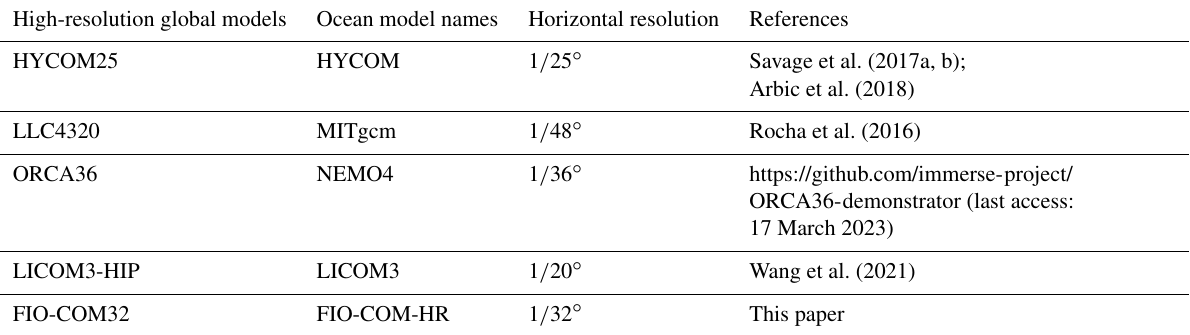
Table 1. Recent developments in global high-resolution ocean